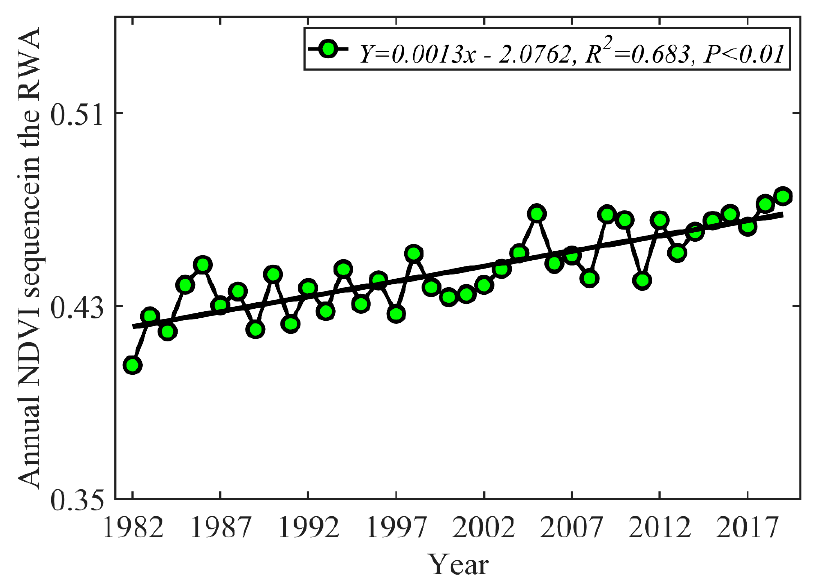
Figure 5. Annual NDVI sequence in the RWA from 1982–2018. The